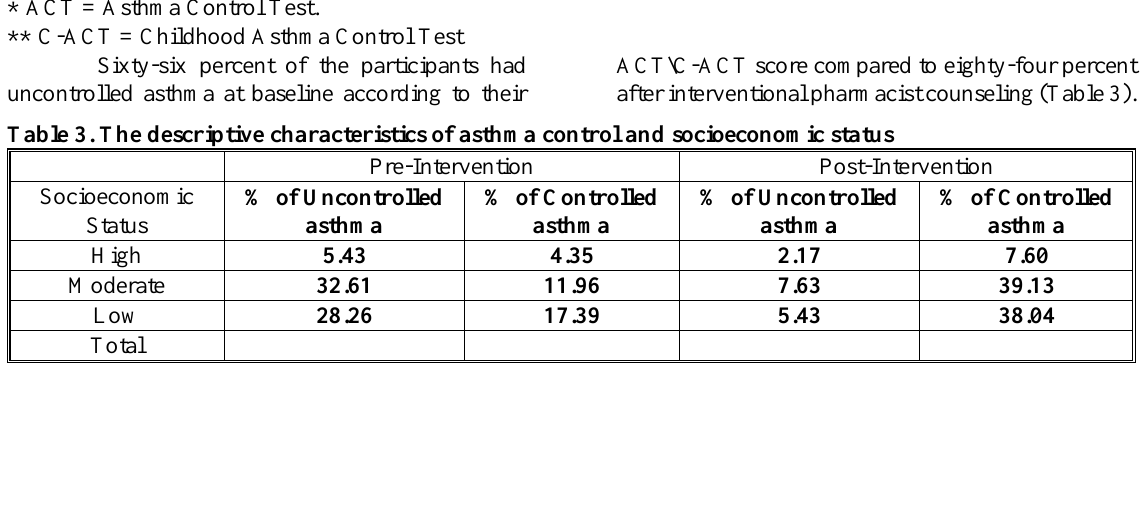
* ACT = Asthma Control Test.